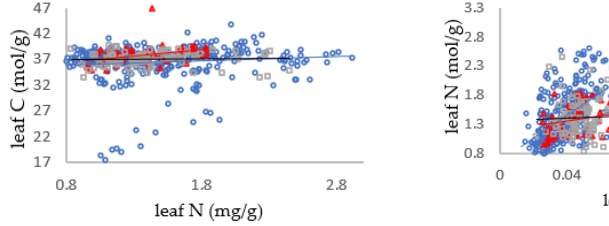
Figure 2. The relationship between the ratio of C, N, and P in leaves for different mycorrhizal types. The blue cycles and blue lines mean AM, the red triangles and red lines mean AM + ECM, and the gray squares and black lines mean ECM.